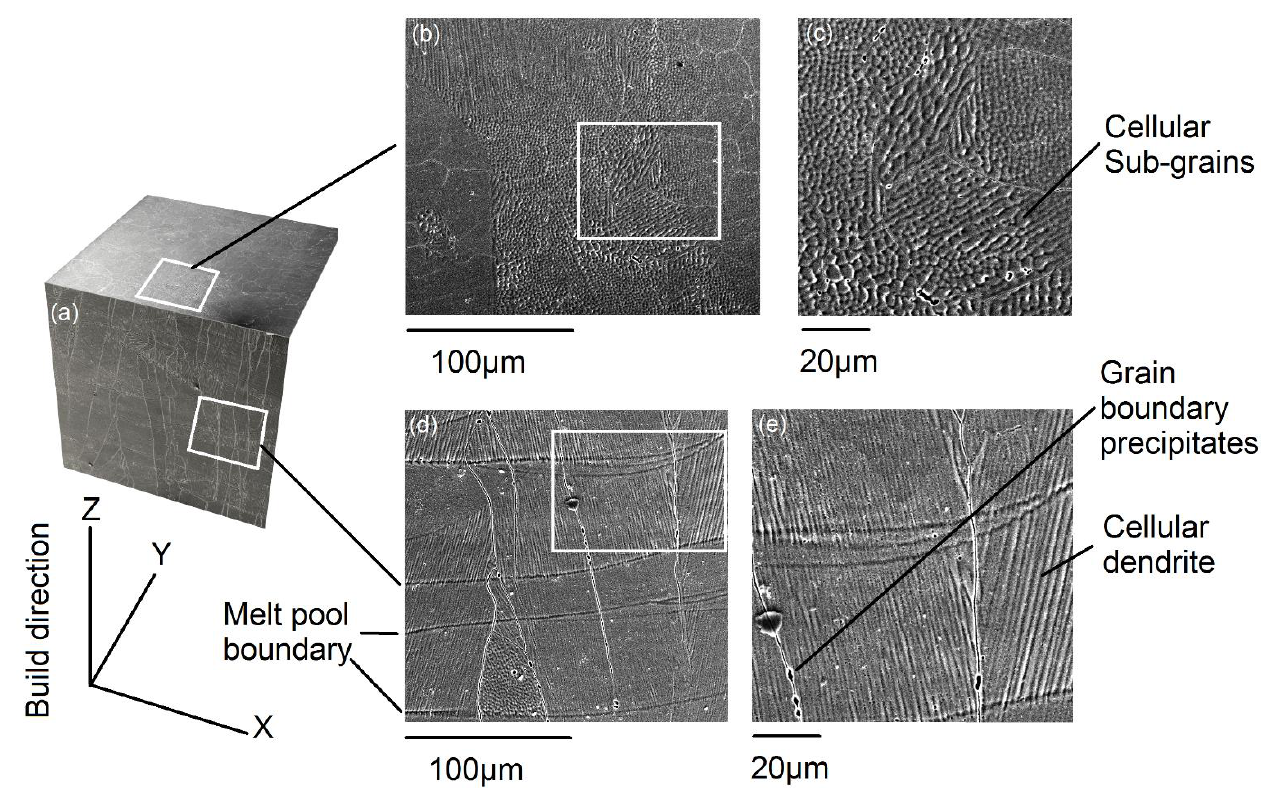
Figure 7. Microstructure of EBM-built 316LN stainless steel samples: ( a ) overview of magnified areas of interest, ( b ) low and ( c ) high magnification scanning electron microscope image of cross section perpendicular to build direction, highlighting cellular sub-grains, ( d ) low and ( e ) high magnification of cross section parallel to build direction showing boundaries of elongated grains, grain boundary precipitates, and cellular dendrites.